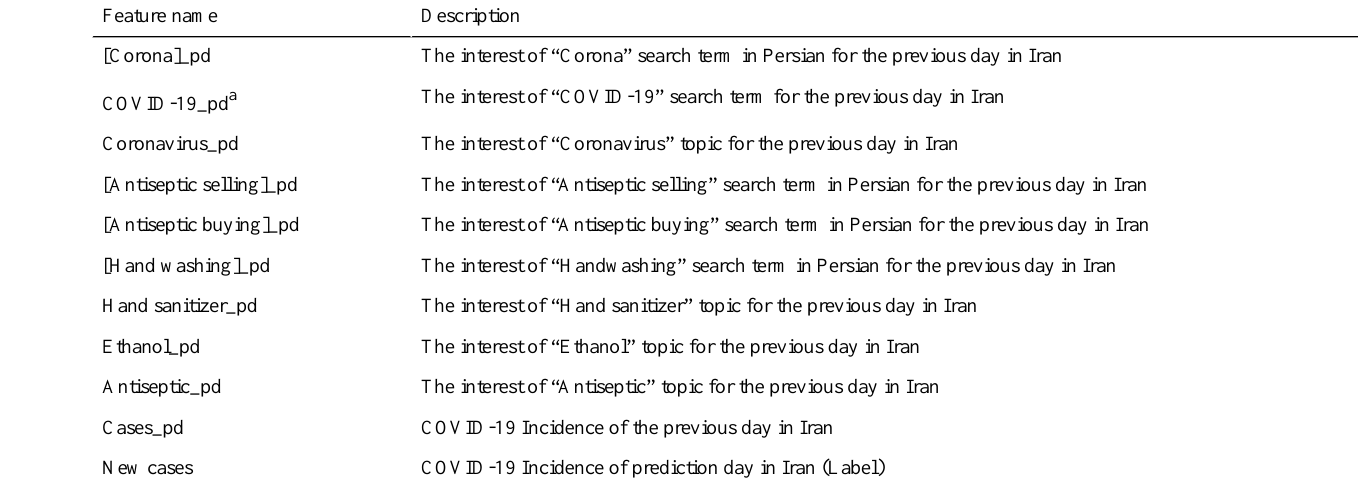
Table 1. Features used for predicting new COVID-19